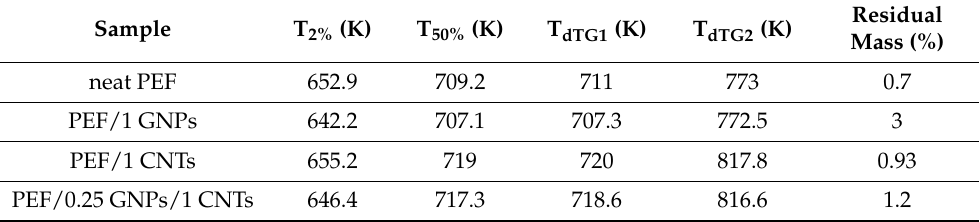
Table 7. Temperatures at 2% and 50% mass loss and the peak temperatures of the dTG curve of neat PEF and its nanocomposites under a dry air